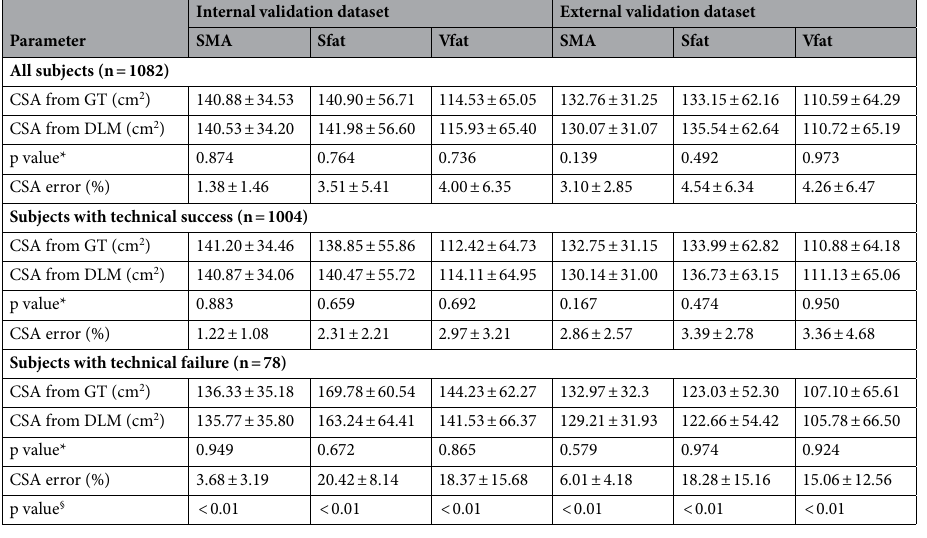
Table 2. Cross-sectional area segmentation using the ground truth-derived and DLM-derived levels. Data are presented as mean ± standard deviation. *The p-value is calculated from Student t-test comparing the GT CSA and the CSA determined using the DLM. § The p-value is calculated from Student t-test comparing CSA errors between subjects with technical success and subjects with technical failure. CSA cross-sectional area, DLM deep learning model, GT ground truth, Sfat subcutaneous fat area, SMA skeletal muscle area, Vfat visceral fat